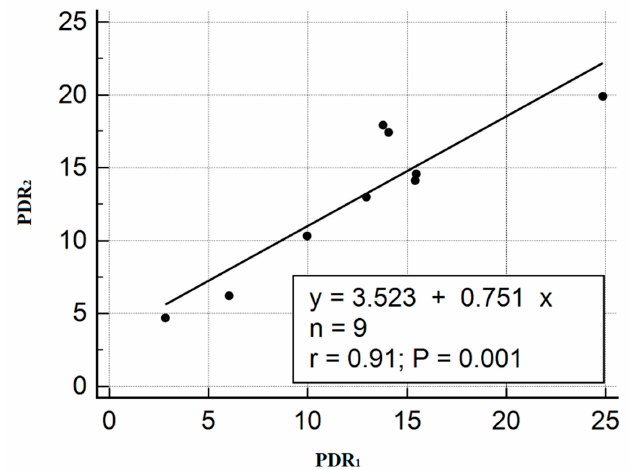
Figure 8. Comparison of plasma disappearance rate (PDR) parameters calculated from the measurements obtained with DU ® 800 UV/Visible Spectrophotometer at the Department of Anesthesiology and Intensive Care of Russian Research Center for Radiology and Surgical Technologies (PDR 2 ), and with our experimental setup (PDR 1